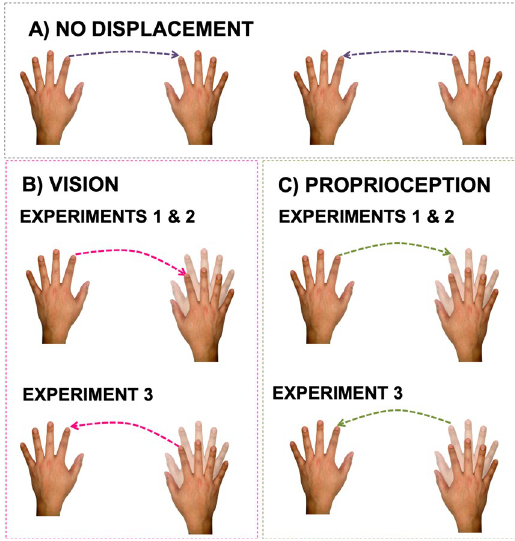
Figure 1. Panel A (NO DISPLACEMENT) depicts the expected movement trajectories (dotted lines) when the VR hand spatially overlapped with the real hand; in the left panel, the left index finger is moved to touch the right index finger whereas in the right panel the right index finger moves to touch the left index finger. In panel B (VISION) and C (PROPRIOCEPTION), the depicted movement trajectories are those that would be observed if subjects relied on vision or proprioception, respectively. In panels B and C, the lighter hand outline represents the veridical position of the subject’s hand on displacement trials whereas the darker hand represents the hand position as defined by